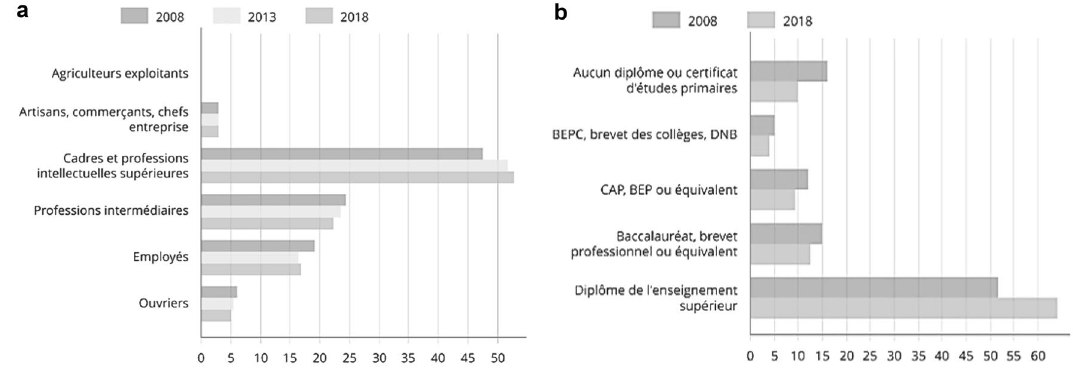
Fig. 2 a Variation of Jobs by socio-professional category (2008–2018). b Highest diploma of the out-of-school population aged 15 or over